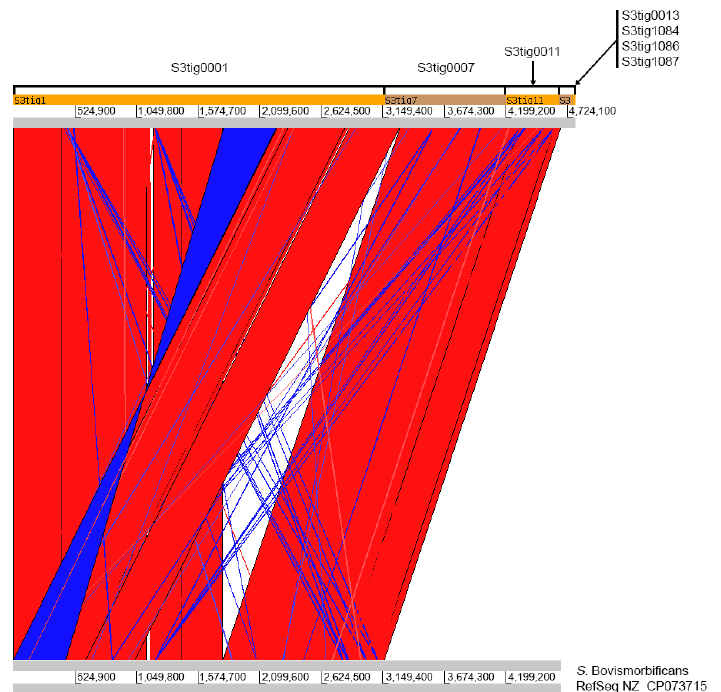
Figure 3. Comparison of the sequences from setting S2 against the reference genome. The contigs are detailed above the query line. Red and blue lines indicate forward and reverse matches, respectively.